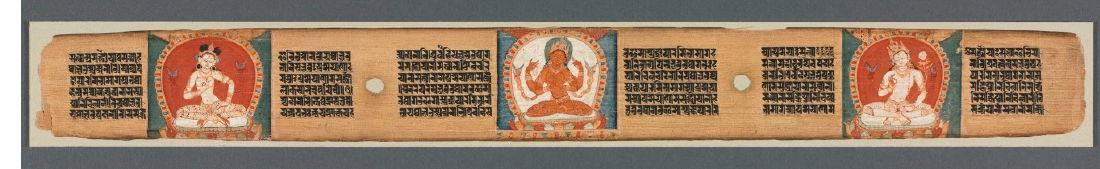
Figure 4. Three female figures, fol. 89v. Perfection of Wisdom in Eight Thousand Lines: A ṣṭ as ā hasrik ā Prajñ ā p ā ramit ā -s ū tra , 1119. India and Nepal. Gum tempera and ink on palm leaf. 5.9 × 55.9 cm. Cleveland Museum of Art, purchase from the J. H. Wade Fund, 1938.301.2.